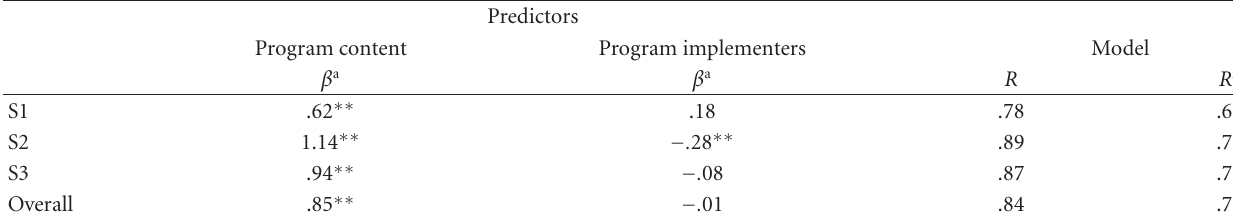
Table 7: Multiple regression analyses predicting program e ff